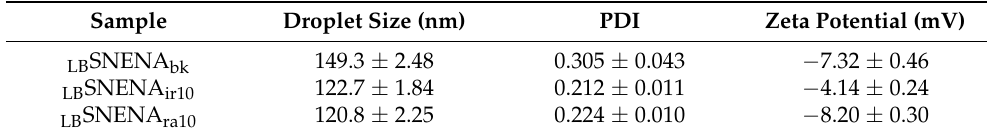
Table 5. The mean droplet size, PDI, and zeta potential of LB SNENA.